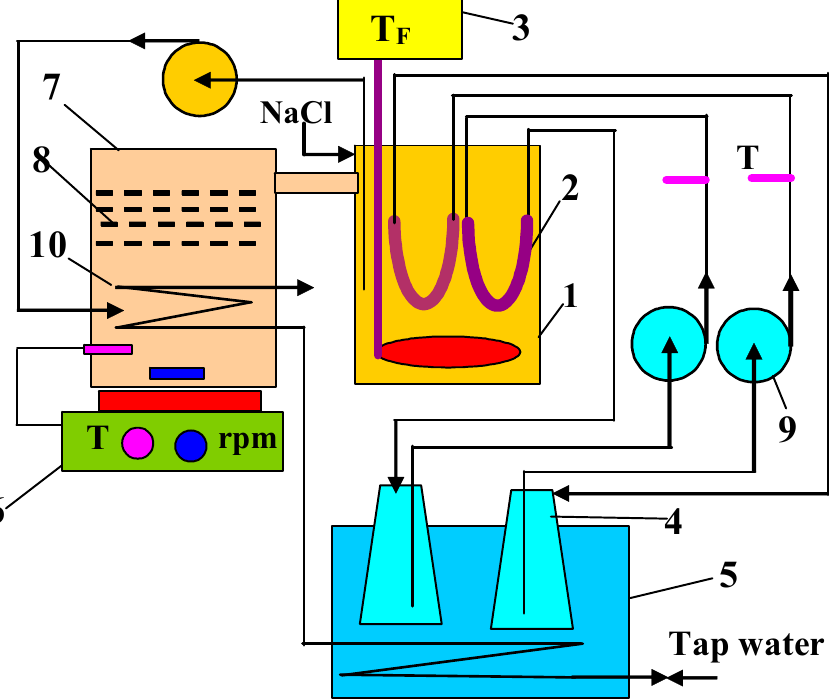
Figure 1. Experimental MDC set-up. 1—feed tank, 2—submerged MD module, 3—feed temperature controller, 4—distillate tank, 5—cooling bath, 6—magnetic stirrer with heating plate, 7—crystallizer, 8—poliamide meshes, 9—peristaltic pump, 10—cooling coil T—thermometer, NaCl—make-up solution (200 g/L).